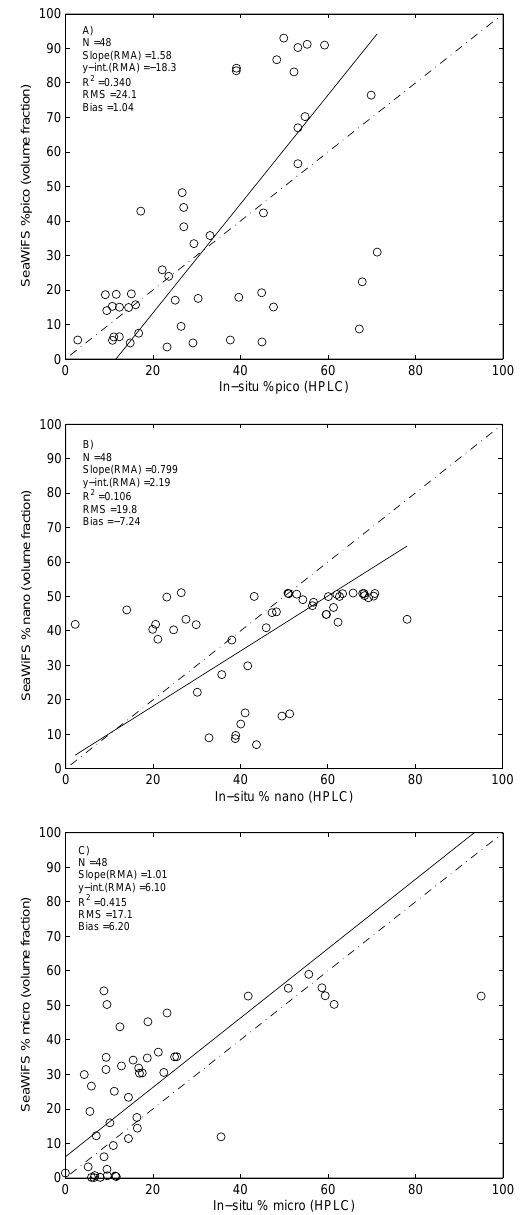
Fig. 3. PFT algorithm validation regressions for (A) percent pi- coplankton, (B) percent nanoplankton and (C) percent microplank- ton. The in-situ PFT’s (x-axes) were calculated using the Vidussi et al. (2001) diagnostic phytoplankton pigment ratio method. Global HPLC surface data were matched to Level-3 daily SeaWiFS im- agery in order to calculate a satellite PFT estimate using the PSD algorithm (y-axes). Type II regressions were used. RMS (Root Mean Square) and bias statistics are independent of the regression